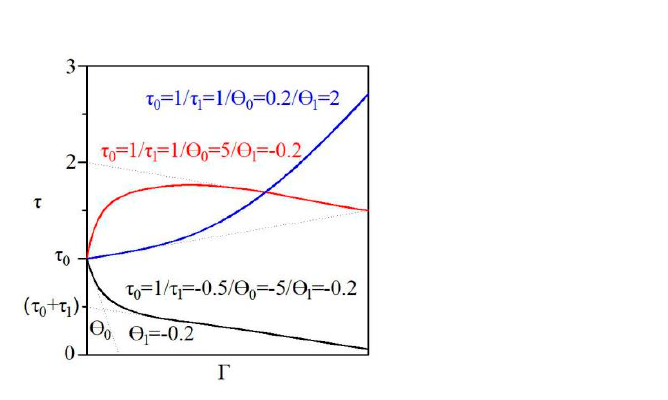
Figure2. Figure 2. Physical meaning of hardening parameters for Viscoplastic Self-Consistent (VPSC) simulations.